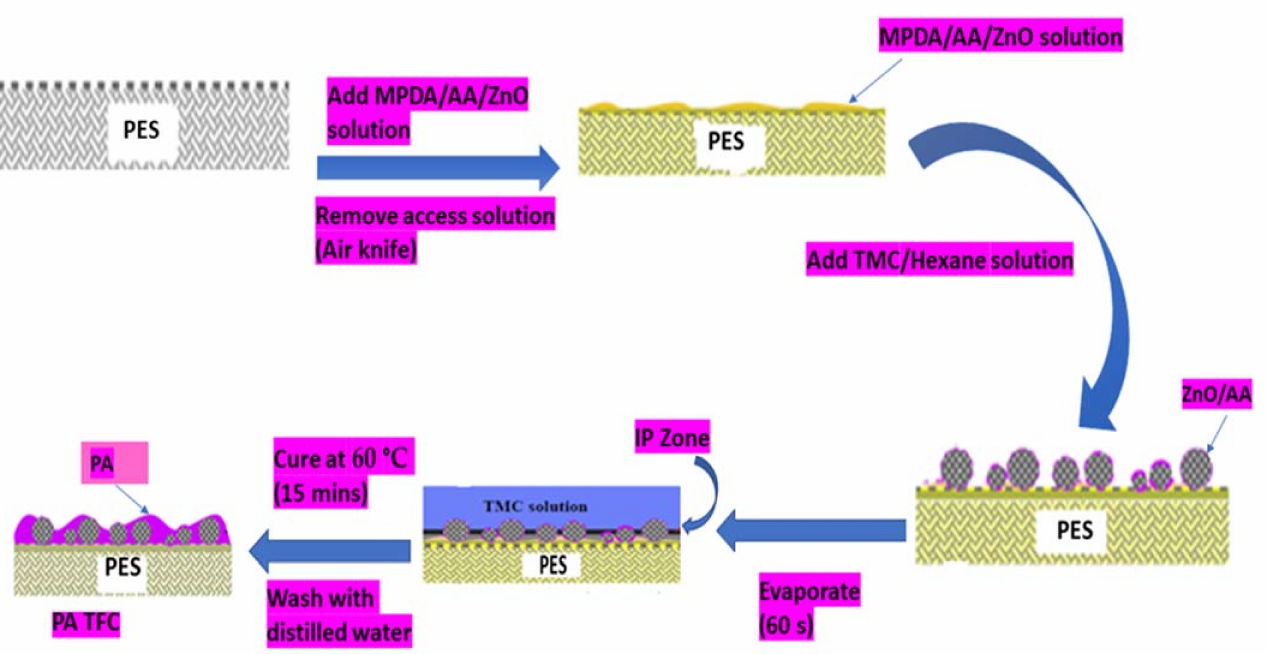
Figure 1. Schematic modification of PA TFC/ZnO/AA membranes through the Interfacial Polymerization (IP)